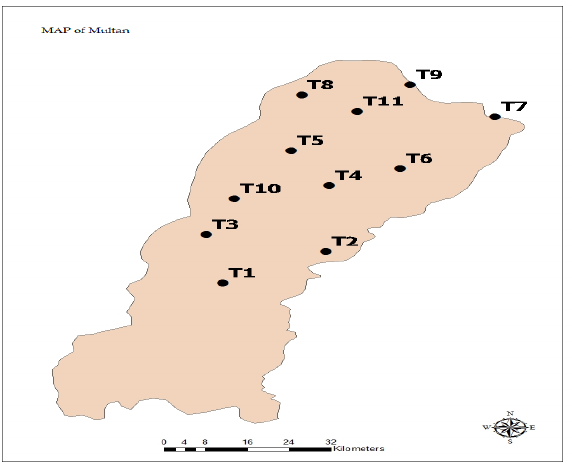
Figure 1. Geographical location map of traps, installed at different sites in the Multan district, Punjab, Pakistan. Table 1. The coordinates i.e., latitude and longitude of the traps, installed in different habitats.